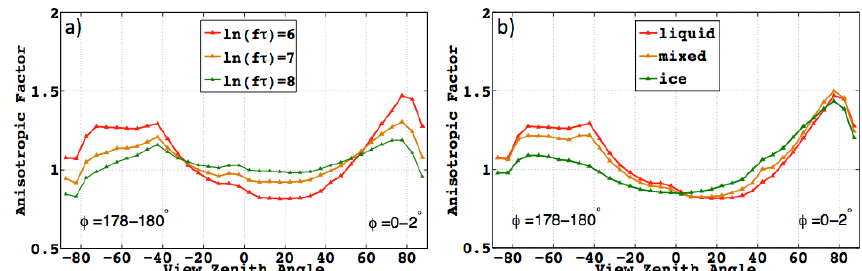
Figure 9. CERES SW anisotropic factors over land in the principal plane for (a) liquid clouds with different ln (f e τ) values, (b) clouds of different phases with ln (f e τ) = 6. Anisotropic factors are derived for θ 0 = 40–45 ◦ based upon 60 months of CERES Terra measurements.